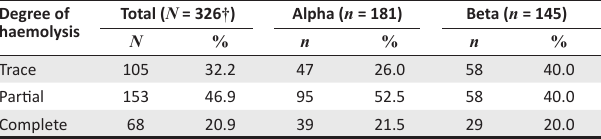
TABLE 2: Degree of haemolysis of alpha and beta haemolysins from blood group O donors at the RHBBB, Cameroon, June 2020–September 2020.